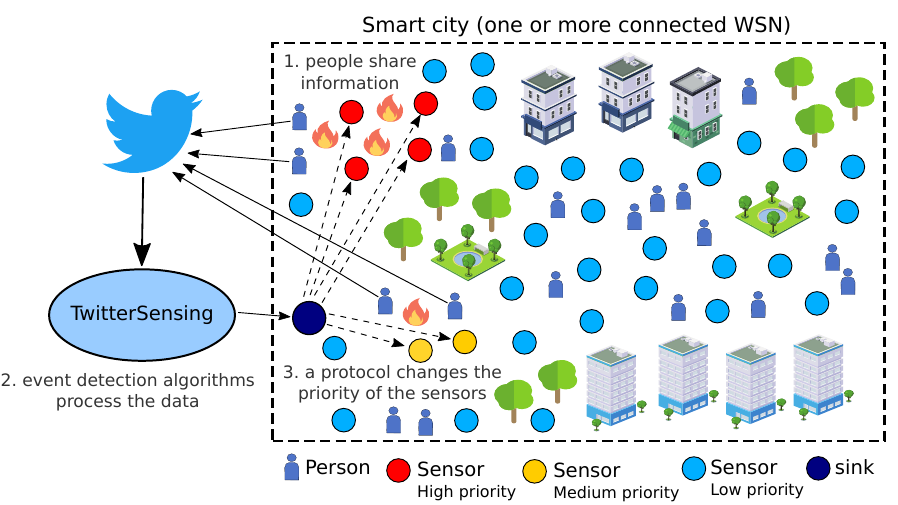
Figure 2. Abstract view of the proposed